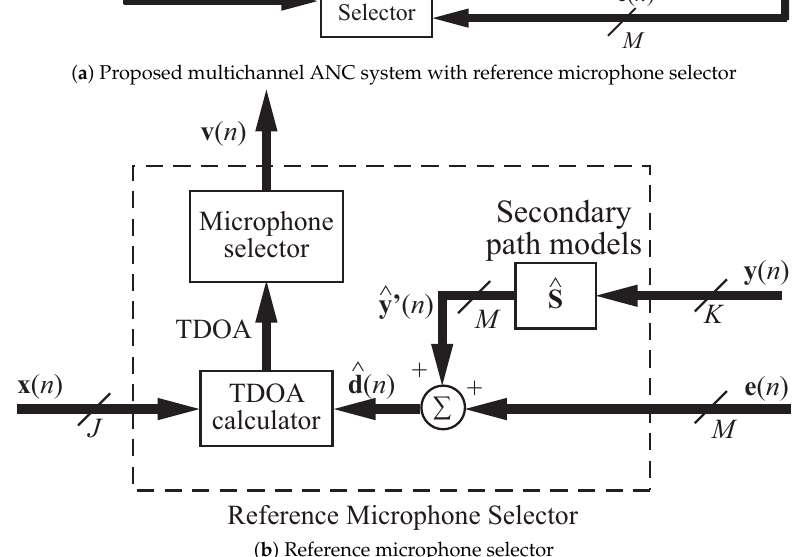
Figure 4. Block diagram of proposed multichannel feedforward ANC system (case ( J , K , M ) ) with reference microphone selector based on TDOA (time difference of